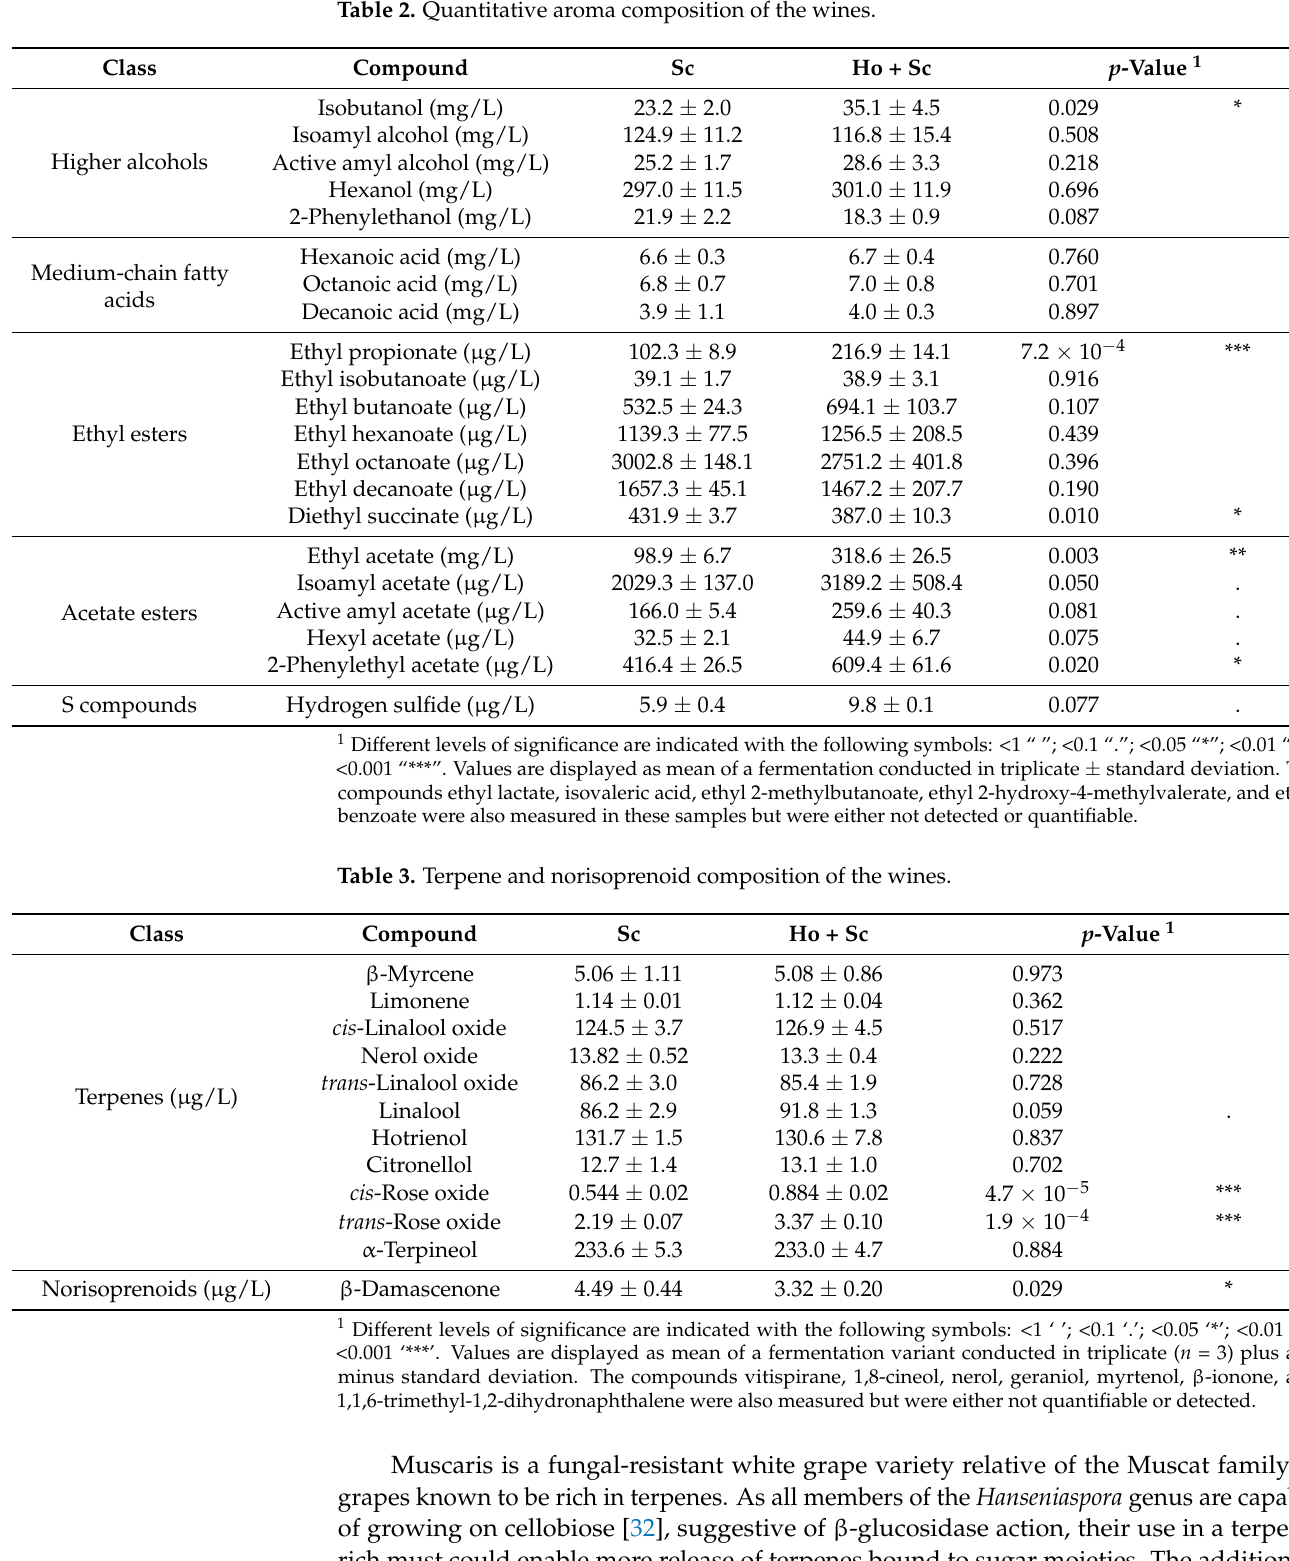
Table 2. Quantitative aroma composition of the wines.